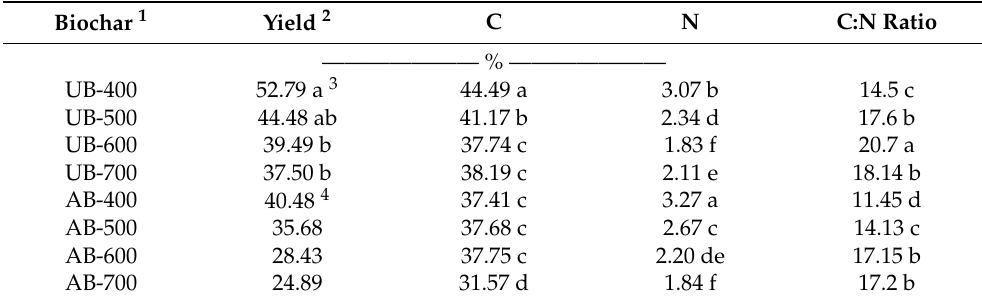
Table 1. Production of biochar from poultry litter at different temperatures (n =